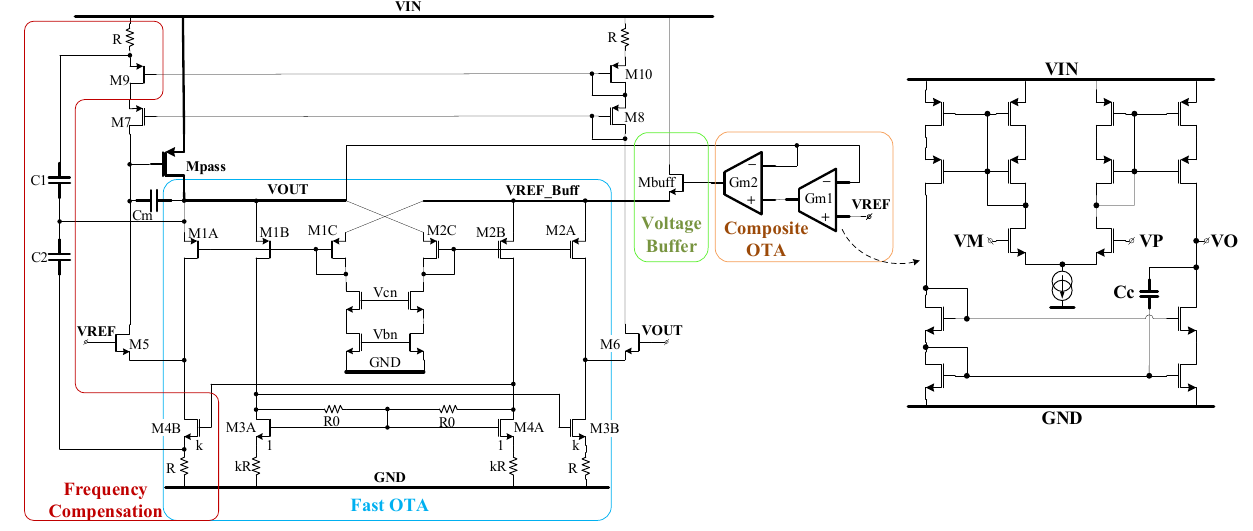
Figure 3. Transistor ‐ level schematic of the proposed fast LDO with multiple feedback loops.